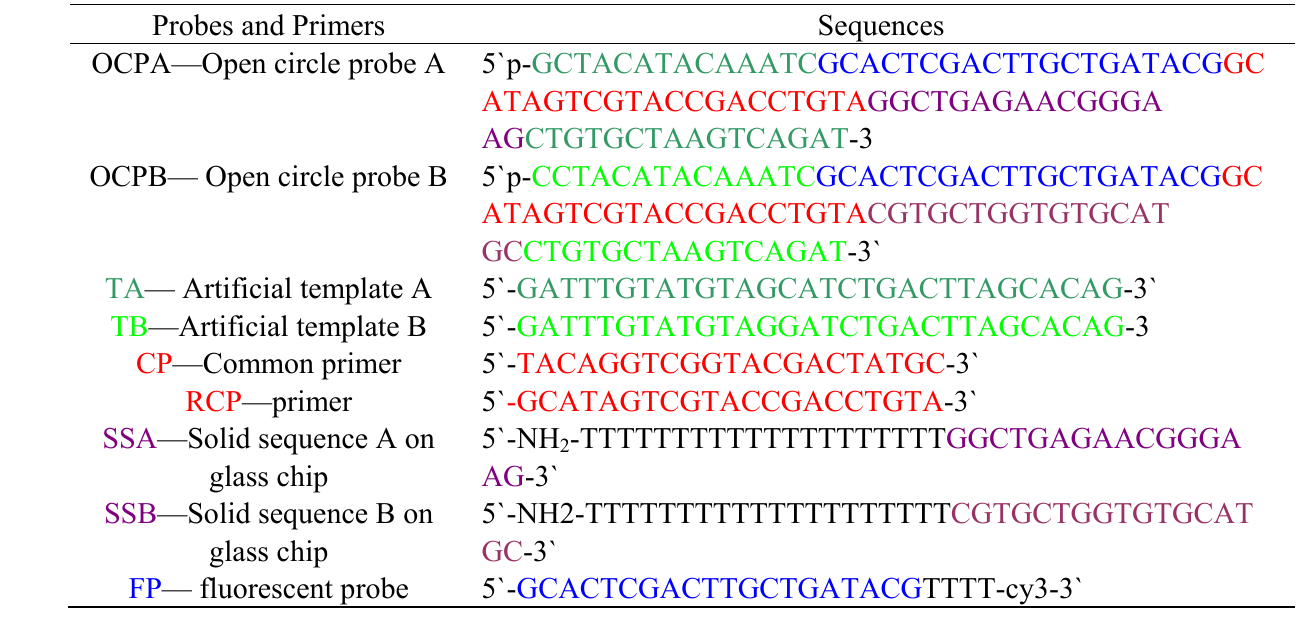
Figure 2. Electrophoresis analysis of RCA product on 1.2% agarose gel. 20